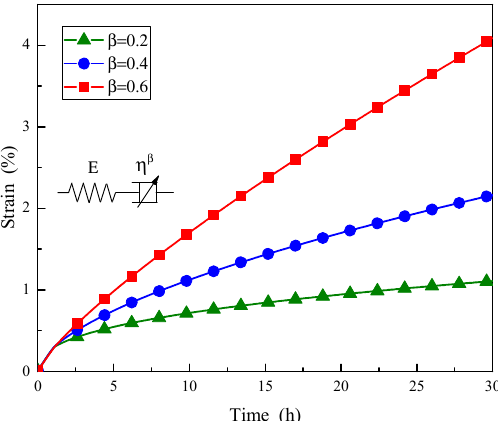
Figure 5. Creep strain of the Maxwell model based on a fractional derivative given by: σ = 20 MPa and η β = 8 GPa · h.